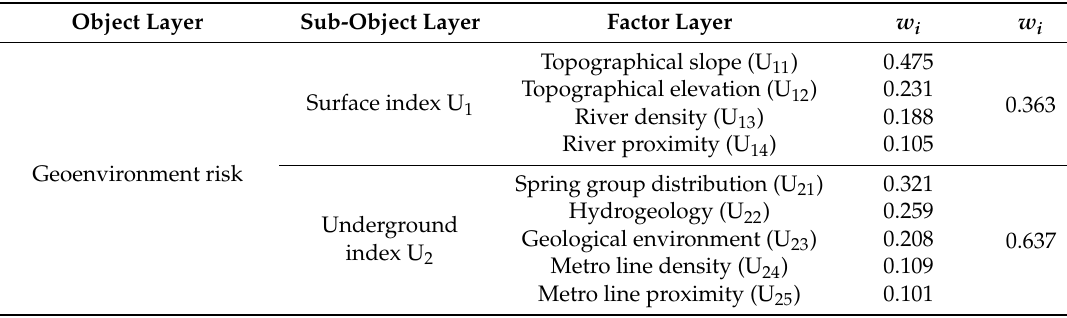
Table 6. Index system for vulnerability assessment in